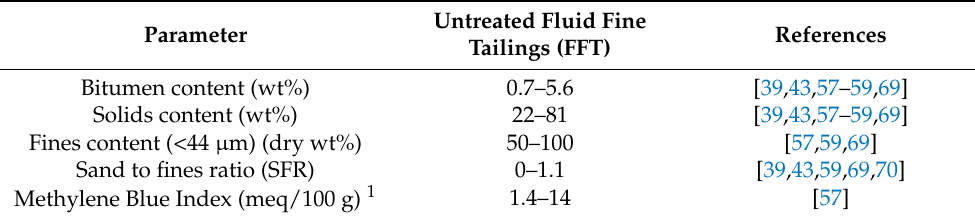
Table 4. Typical range of bitumen, solids, and fines content in untreated oil sands fluid fine tailings.